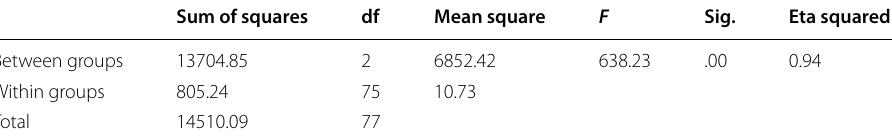
Table 7 Results of one-way ANOVA: the participants’ posttest of speaking accuracy scores Sum of squares df Mean square F Sig. Eta squared Between groups 13704.85